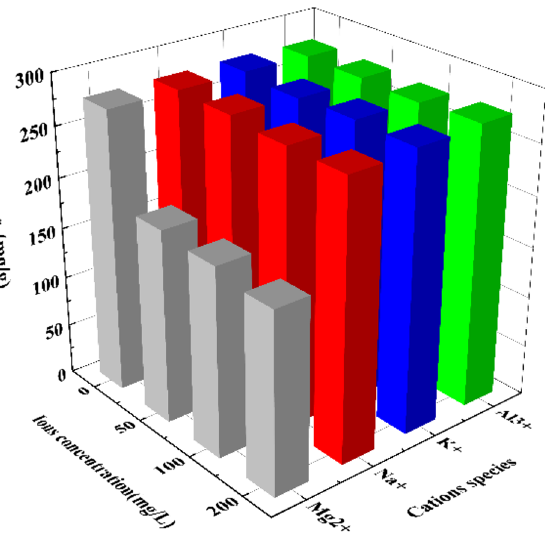
Figure 13. Effect of cations on the adsorption of U(VI) by ZnNiA1-LDHs ( C 0 (U) = 35 mg L −1 , m/V = 0.125 g L −1 , pH = 6.0, t = 6 h, T = 303 K).